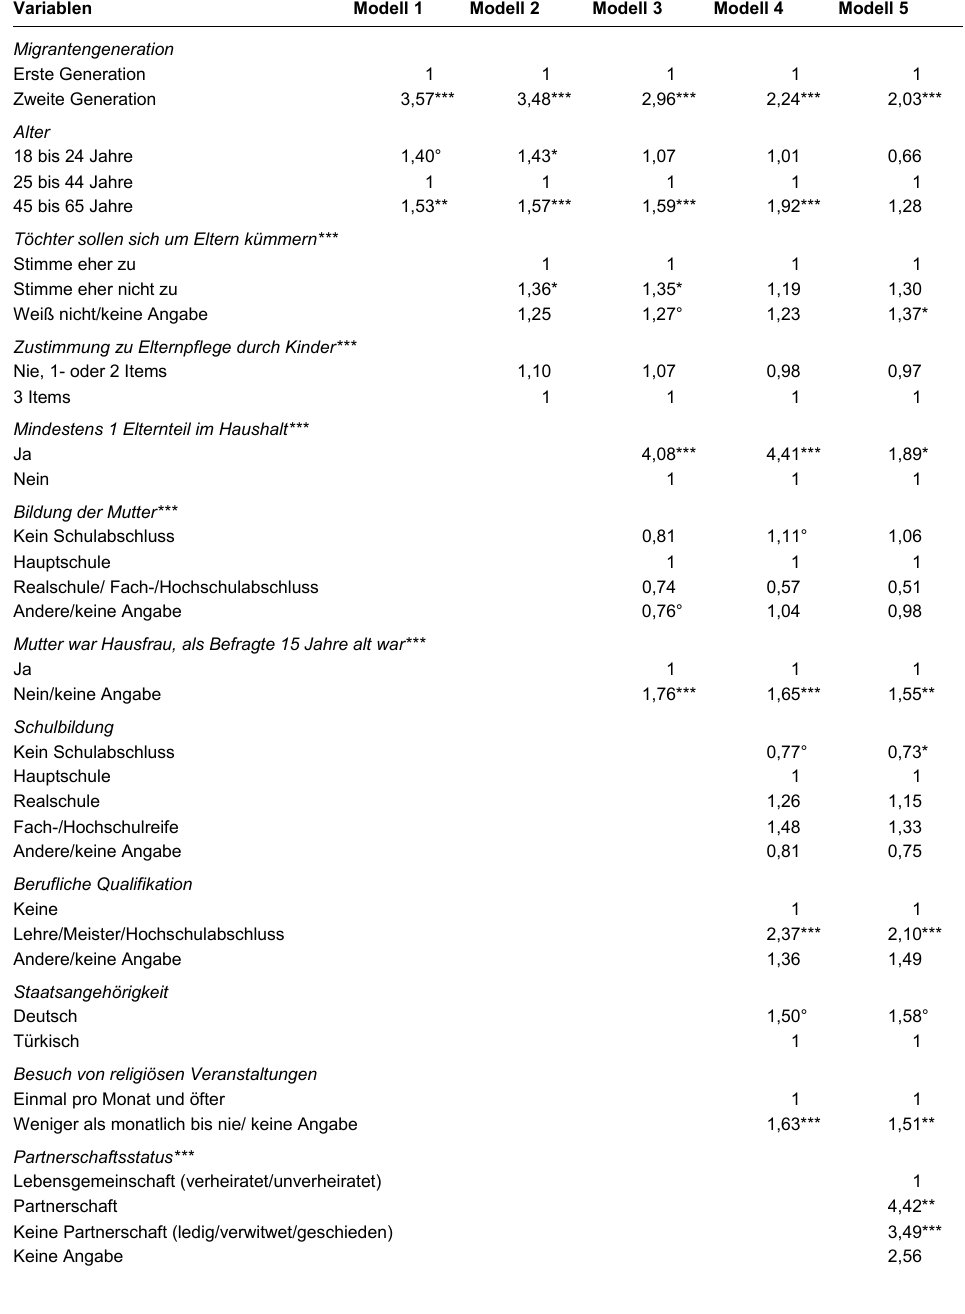
Tabelle 2: Einflussfaktoren der Erwerbsbeteiligung (odds ratios)